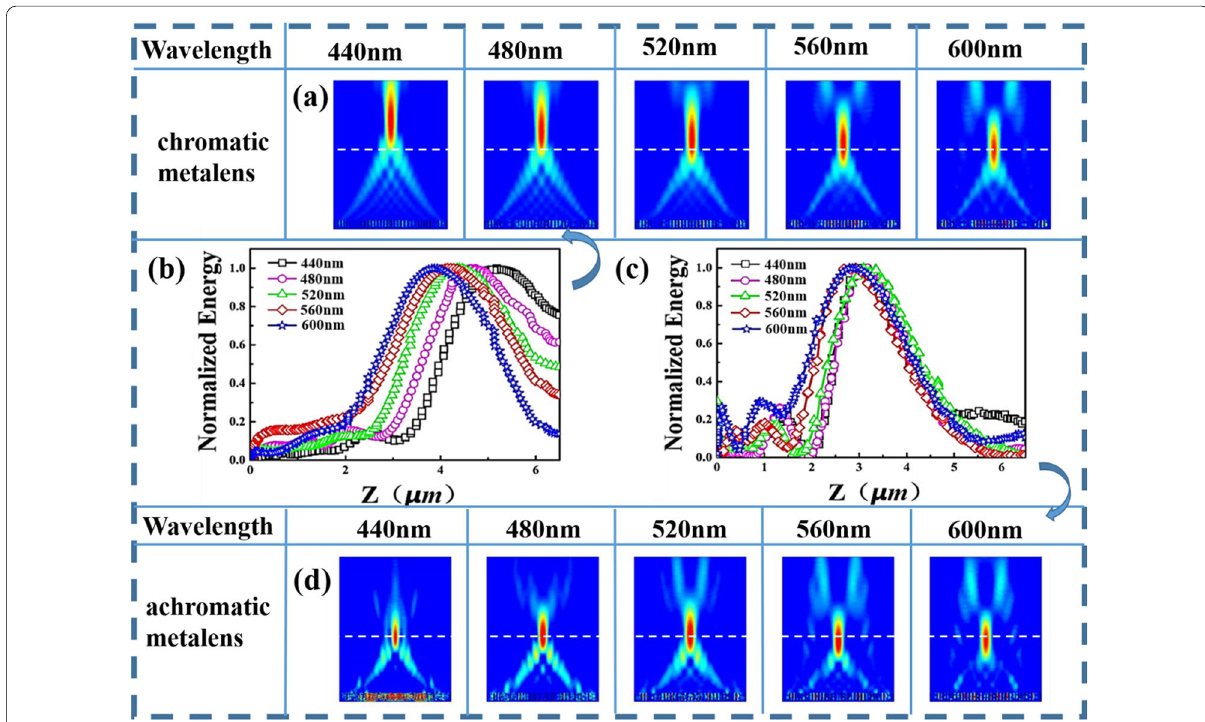
Fig. 3 a Electric field distribution on the optical axis of a chromatic metalens. b and c Normalized energy on the optical axis of a chromatic metalens modulated by PB phase only and achromatic metalens modulated by PB phase combined with propagation phase, respectively. d Electric field distribution on the optical axis of an achromatic